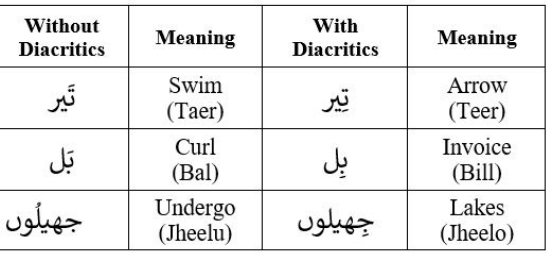
Figure 3. Urdu Diacritics Example.